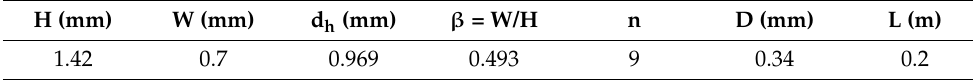
Table 1. Geometrical configuration of the tube.